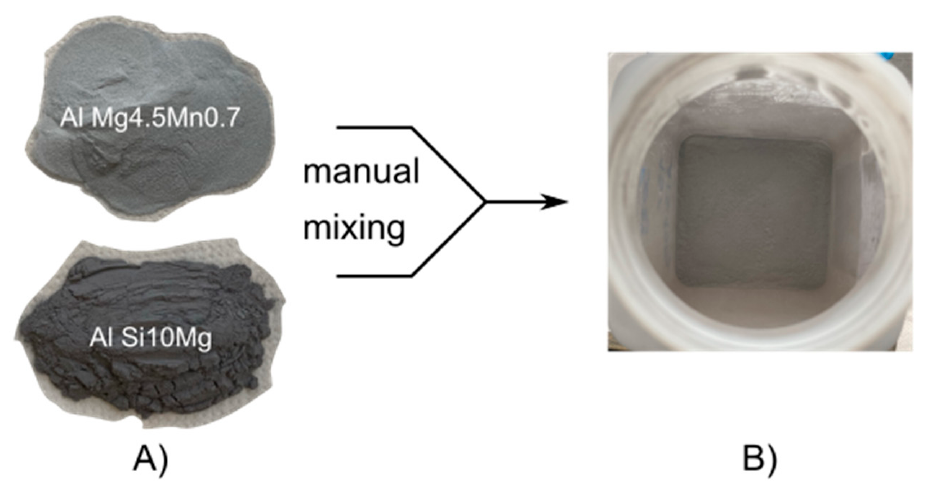
Figure 2. ( A ) Base alloy EN AW-5083 (AlMg4.5Mn0.7) was mixed with the supplement AlSi10Mg powder. ( B ) Homogeneous mixture by manually shaking the two powders in a sealed container. The powder size distribution for EN AW-5083 was D10 = 26.36 µ m, D50 = 41.37 µ m, and D90 = 62.16 µ m for the respective percentile quantile. For AlSi10Mg it was D10 = 14.53 µ m, D50 = 30.13 µ m, and D90 = 44.14 µ m. The powder supplier measured and provided this data with a dynamic image